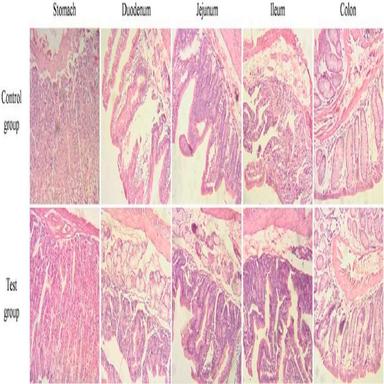
Histological images of different gastrointestinal segments.